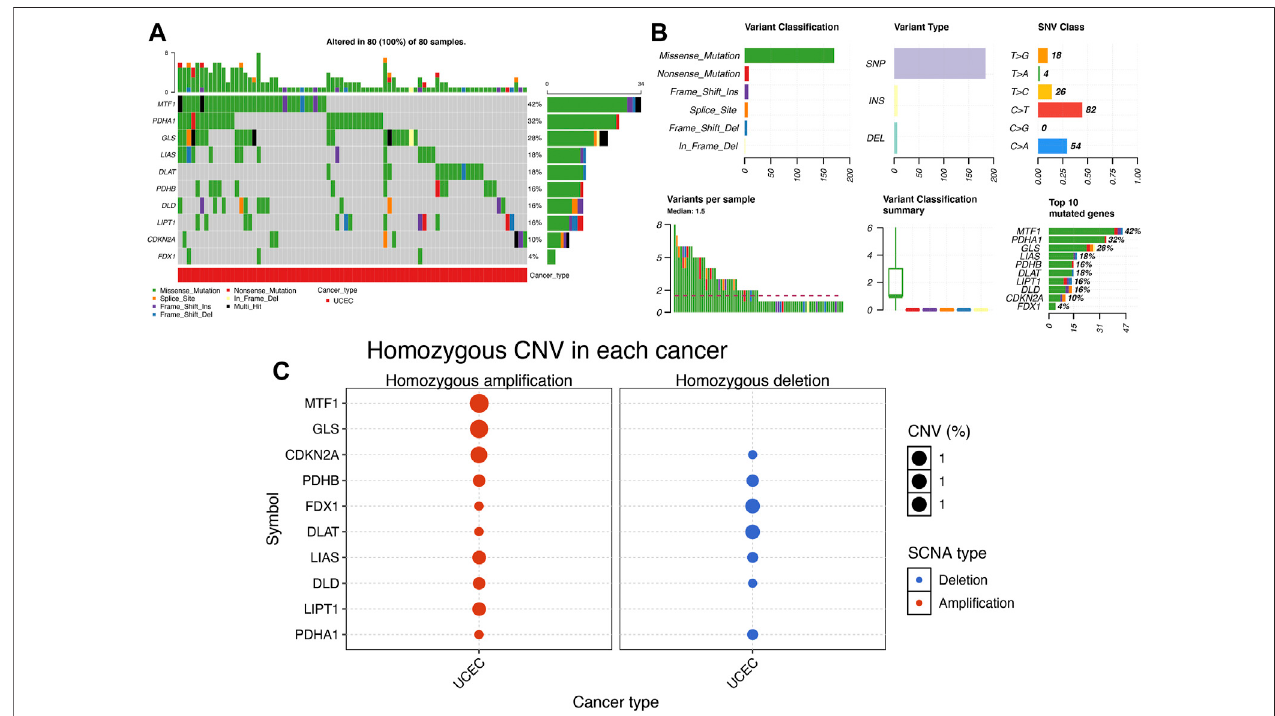
FIGURE2| Mutationlandscapeofcuproptosis-relatedgenes(CRGs)inuterinecorpusendometrialcarcinoma(UCEC). (A,B) Singlenucleotidevariationanalysisof CRG in UCEC. (C) Copy number variation analysis of CRG in UCEC.